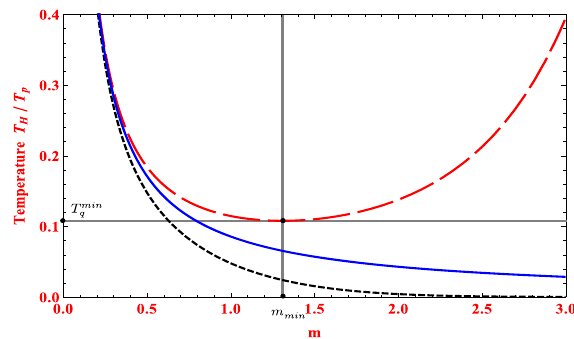
Fig. 1 The figure shows the temperature of a Schwarzschild BH as a function of masses in the asymptotically flat case with Boltzmann ( q = 1, blue-continuous) and Tsallis entropies ( q > 1, red-dashed and q < 1, black-dotted)